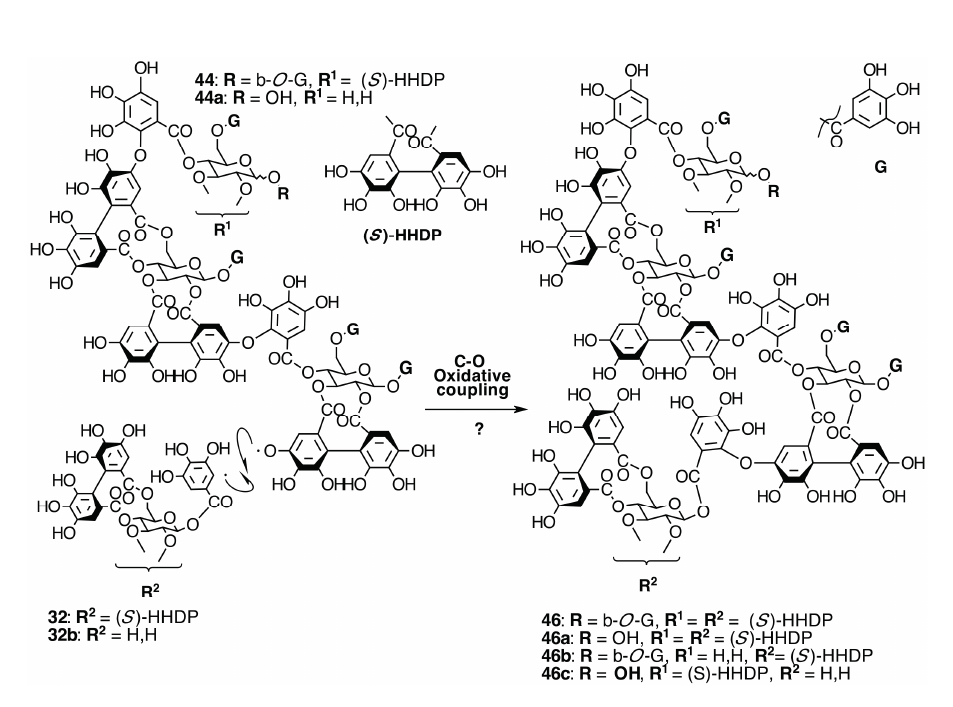
Figure 20. Route K in the biogenesis of tetrameric ellagitannins in Melastomataceae. ? = Enzymes and reaction conditions are not yet